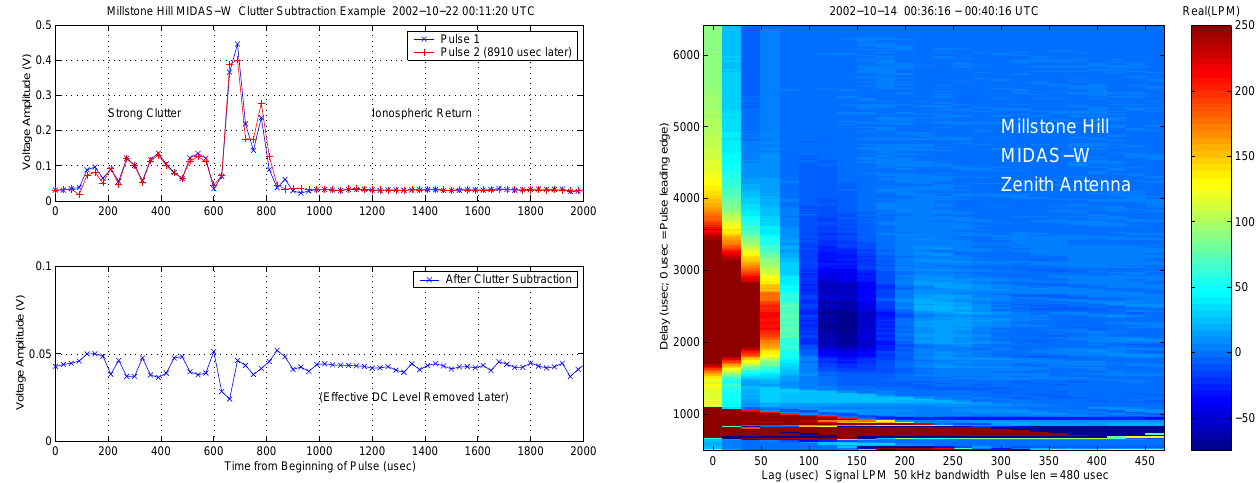
Fig. 7. A typical example of LPM level information from the Mill- stone Hill Software Radar implementation. Here, data is shown from the real portion of the LPM for a four-minute integration us- ing a 480 µs pulse. Lags are computed at 20 µs